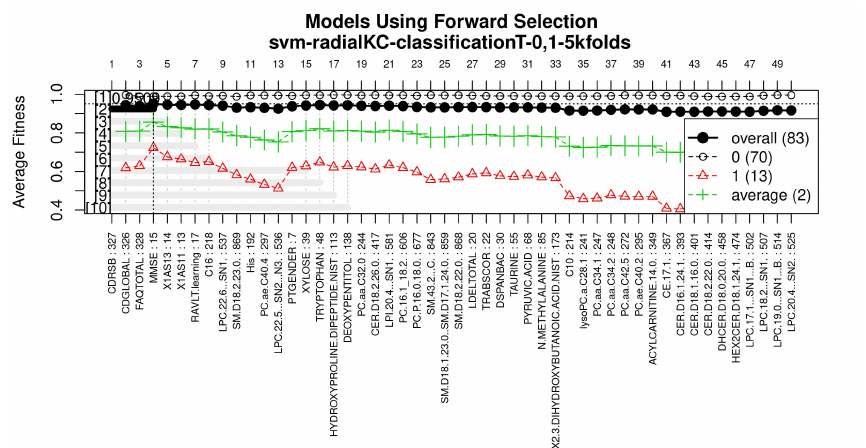
Figure 4. Evolution of the maximum fitness score across generations. The horizontal axis represents a given generation, whilst the vertical axis represents the fitness score. The average fitness, plotted with a blue solid line, considers all models. The average unfinished fitness, plotted with a cyan solid line, considers all searches that failed for a given generation and represents the average worst case expectation. The established GA goal fitness is plotted with the red dotted line. For a zoomed view see Figure A2.